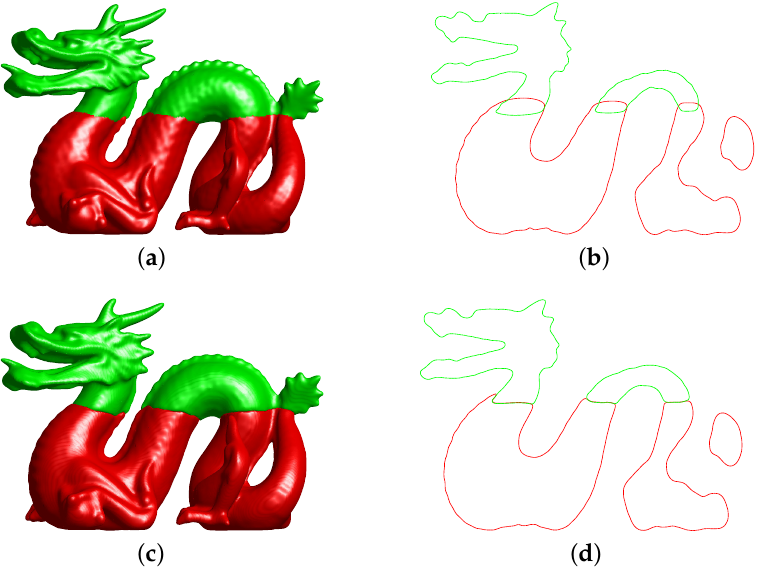
Figure 5. ( a , c ) The results of Poisson reconstruction and our proposed method in the whole view, respectively. ( b , d ) The results in the cross-view of ( a , c ), respectively.